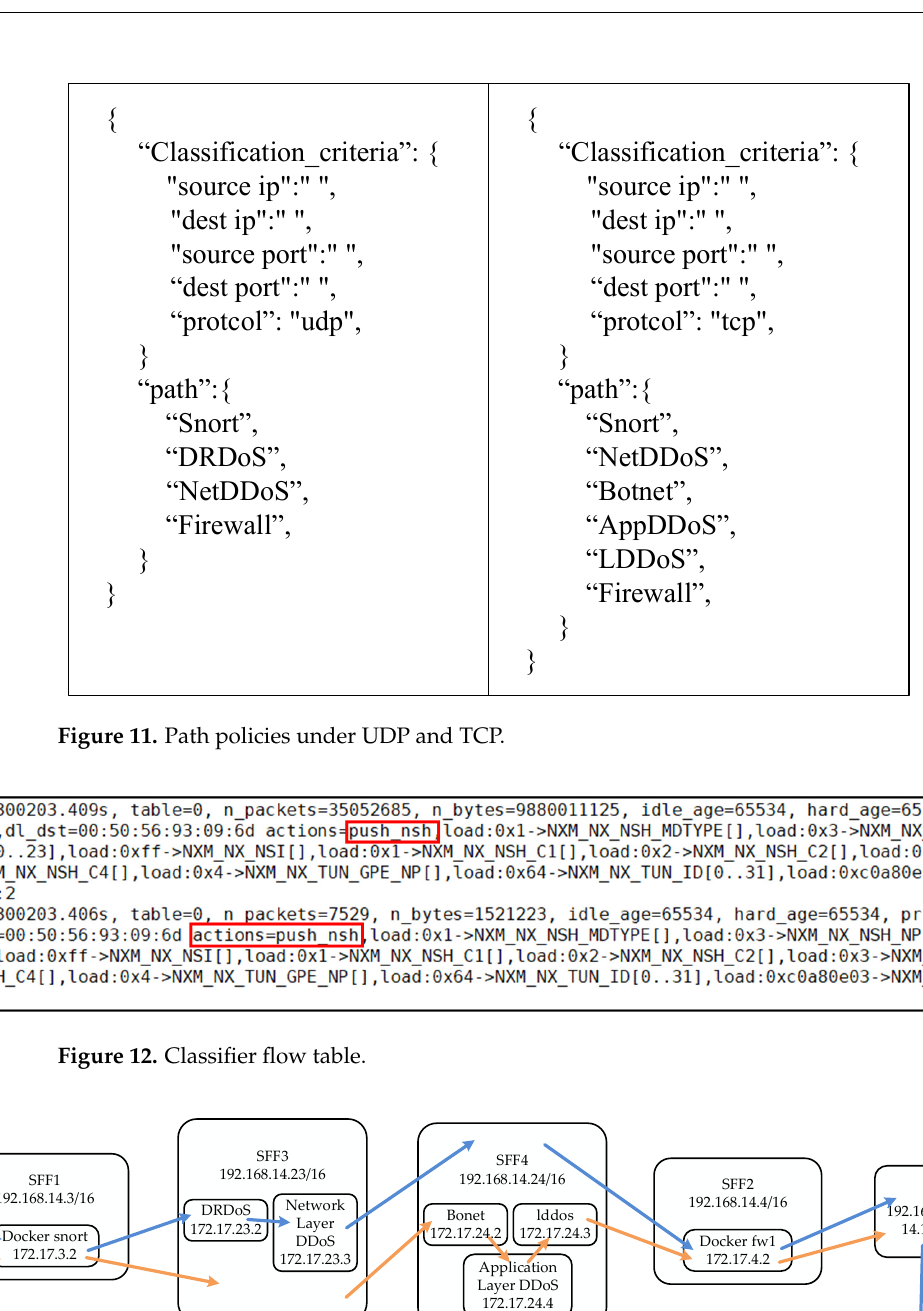
Figure 12. Classifier flow table.